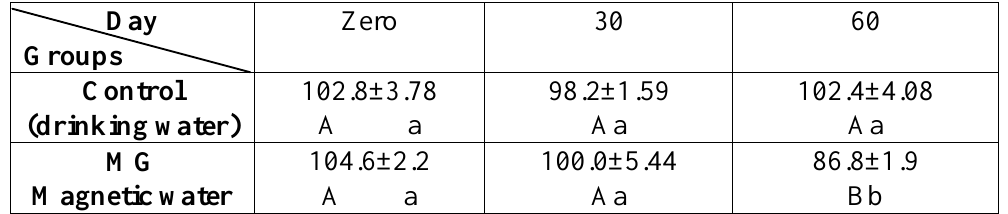
between groups, P<0.05 vs. control. Small letters denote non significantdifferences within group. Table (5): Effect of exposure to magnetized water for 60 days on serum triacylglycerol